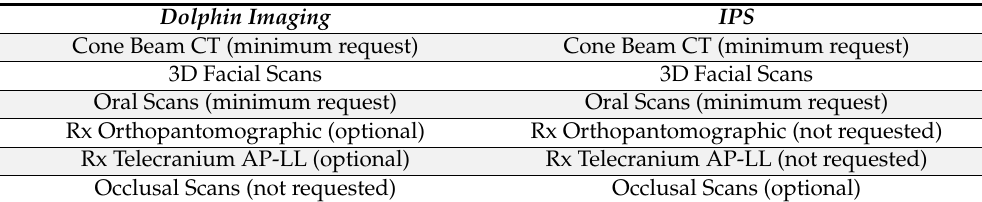
Table 2. Fundamental investigation required for a complete surgical